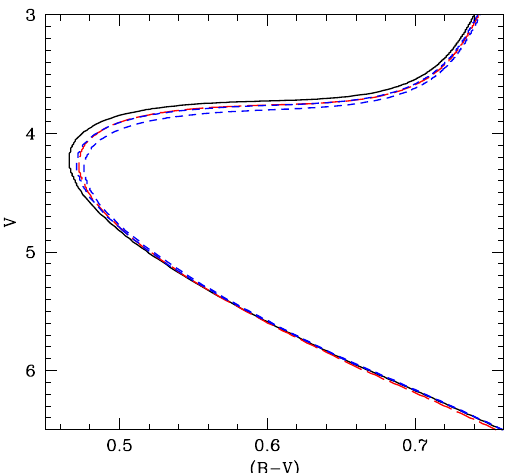
Figure 1. ( V,B − V ) color-magnitude diagram (CMD) of a t = 12.0 Gyr simulated isochrones for A V = 1 (red dashed line), compared to a set of unreddened isochrones with t = 12.0 (solid black line), 12.5, and 13.0 Gyr (dashed blue lines) according to the procedure discussed in the text.